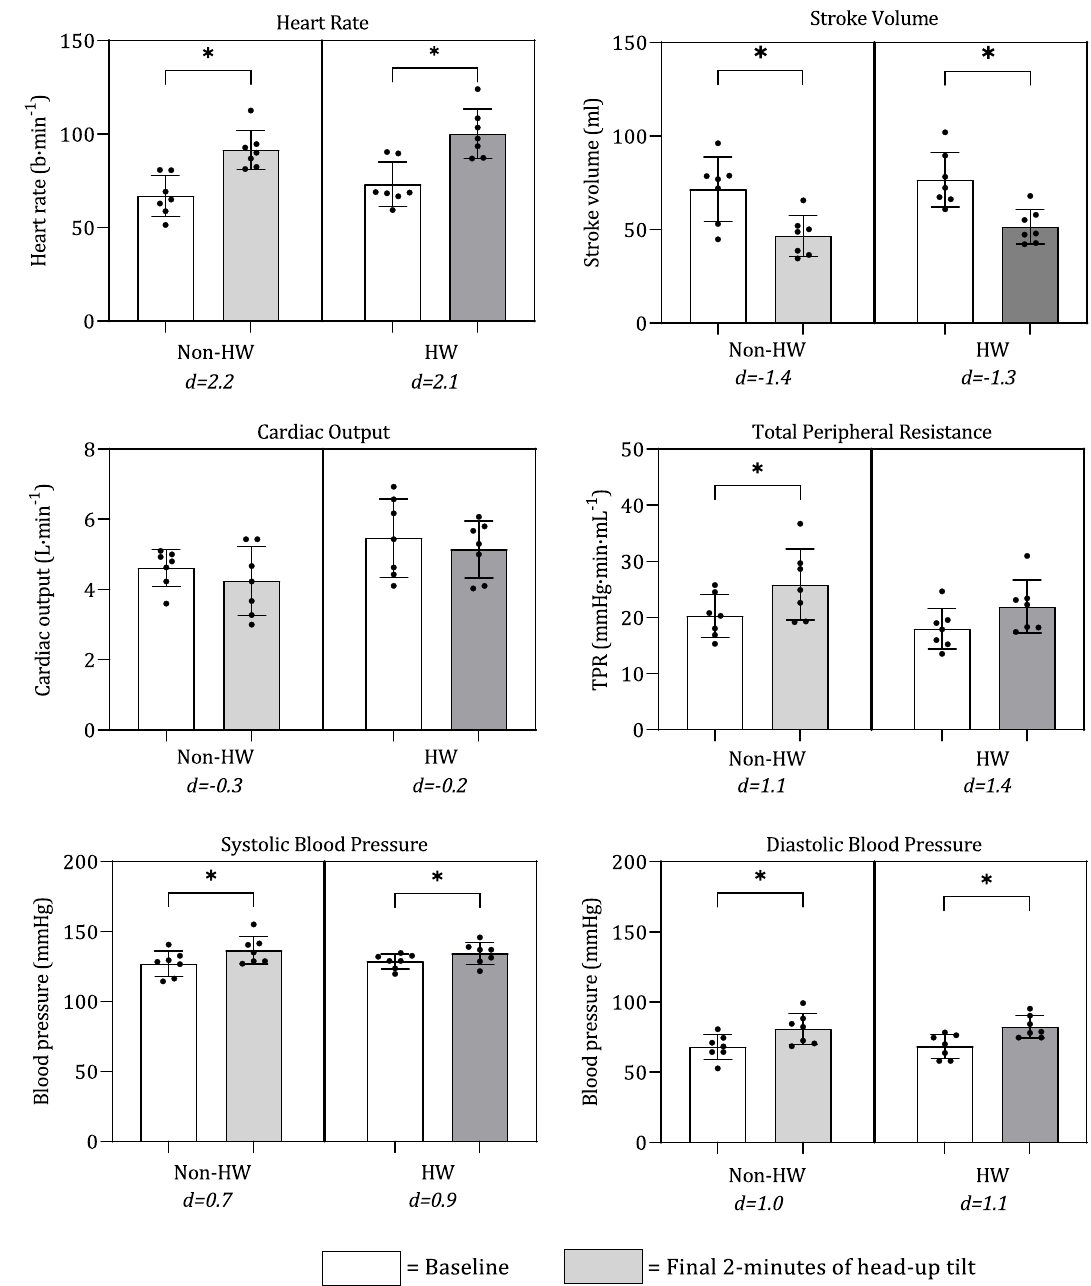
Figure 1. Cardiovascular responses to 60° head-up tilt (HUT) during non-HW and HW. Mean ± SD and individual responses to heart rate (HR, b·min -1 ), stroke volume (SV, ml), cardiac output (CO, L·min -1 ), mean arterial pressure (MAP, mm Hg), and total peripheral resistance (TPR, mmHg·L·min -1 ). Significant differences between postures in each condition denoted with an asterisk (*). Cohen’s D effect sizes presented below ambient conditions, indicating the size of effect between supine and HUT in each ambient